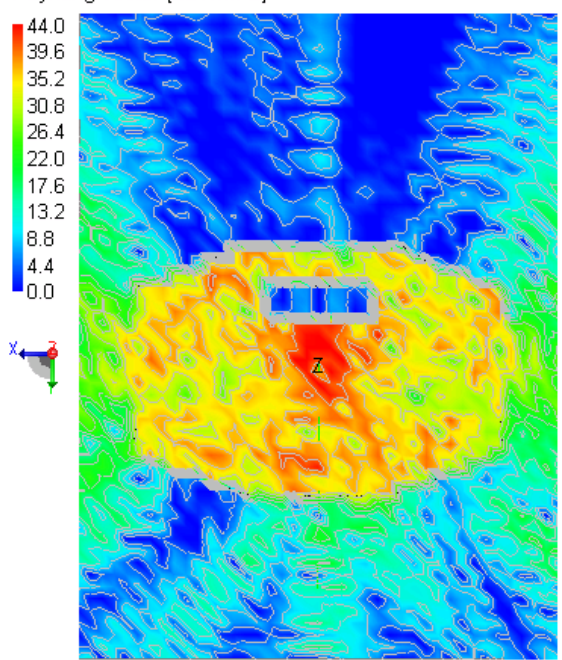
Figure 5. Poynting vector radiation pattern due to sinusoidal excitation of the